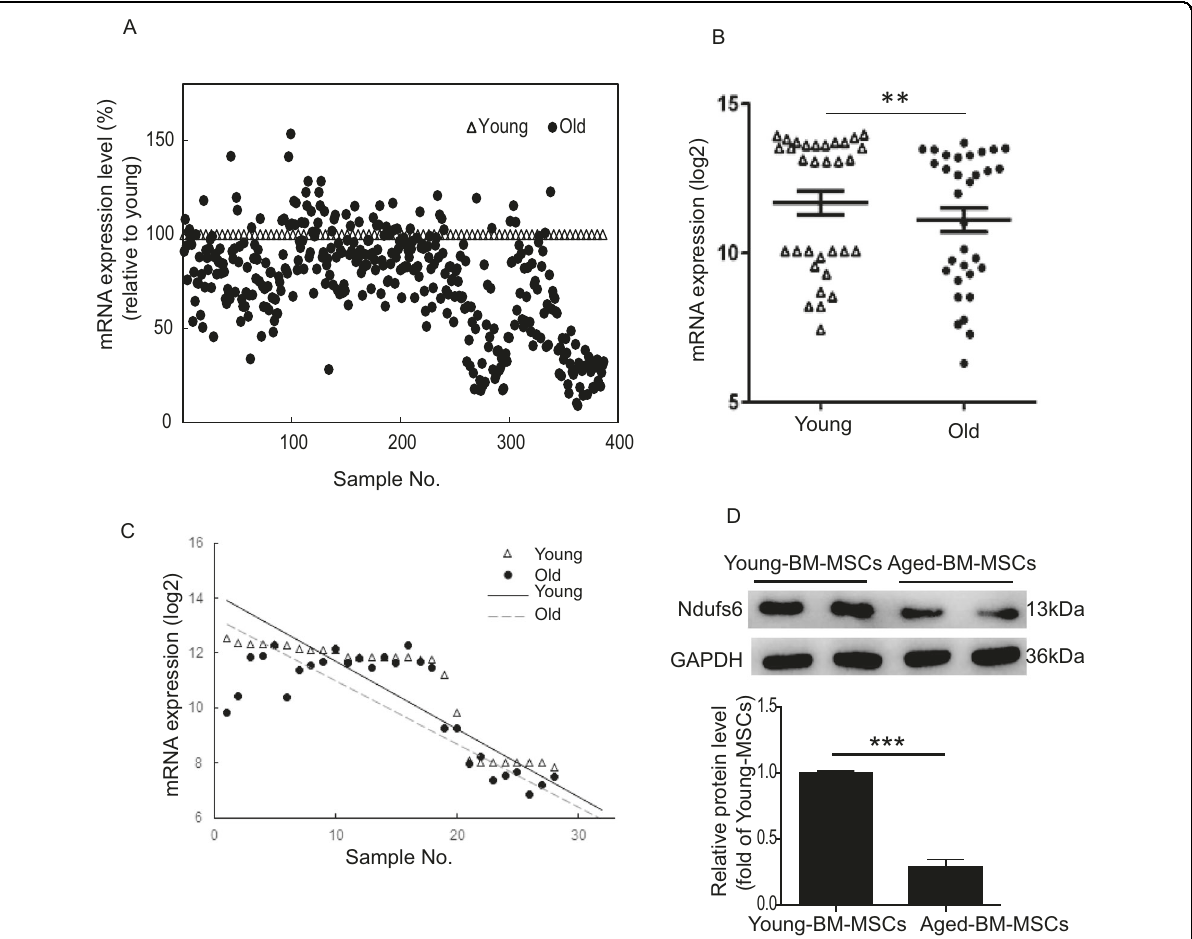
Fig. 1 mRNA expression change of Ndufs6 during aging in human or mouse MSCs. mRNA expression data were extracted from fi ve microarray datasets representing young vs. old/senescent cells and tissues or early stages of MSC differentiation. A Scatter plot for mRNA expression (relative to young) for all subunits (Ndufs1 – 8) of mitochondria complex assembly I. B mRNA expression difference of Ndufs6 between young and old cells or tissues ( n = 32). C Linear regression of mRNA expression of Ndufs6 between young and old cells or tissues ( n = 30). D The protein level of Ndufs6 in young-BM-MSCs and aged-BM-MSCs isolated from mice was determined by western blotting. Signi fi cant difference between young and old cells or tissues, **p < 0.01 ***p <